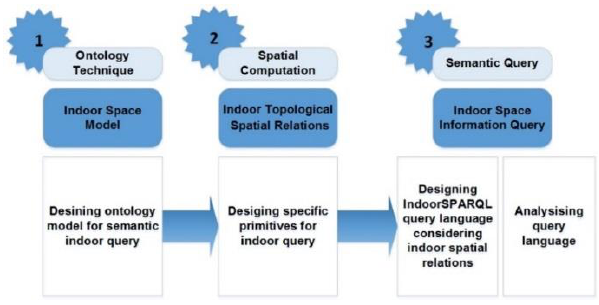
Figure 1. Overview of proposed